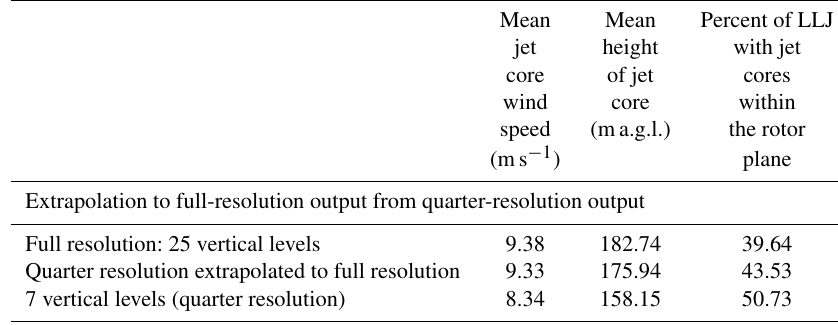
Table 6. For winter months (December, January, February) – spatially and temporally averaged LLJ properties as a function of model output vertical resolution for full-resolution and quarter-resolution output as well as quarter-resolution output extrapolated to full-resolution output through polynomial